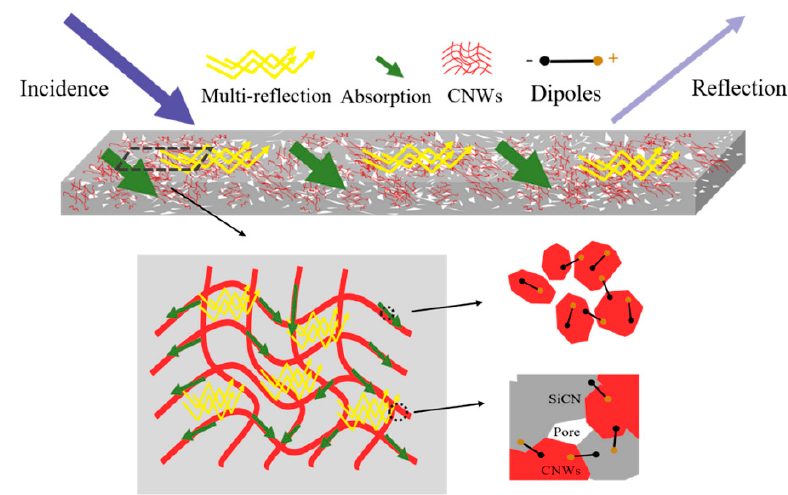
Figure 9. Schematic illustration of the interaction of electromagnetic wave with the wires and possible electromagnetic absorption mechanisms in carbon nanowires (CNWs)/SiCN composite ceramics [30]. Reproduced with permission from Ren F., Ceram. Int.; published by Elsevier, 2019.